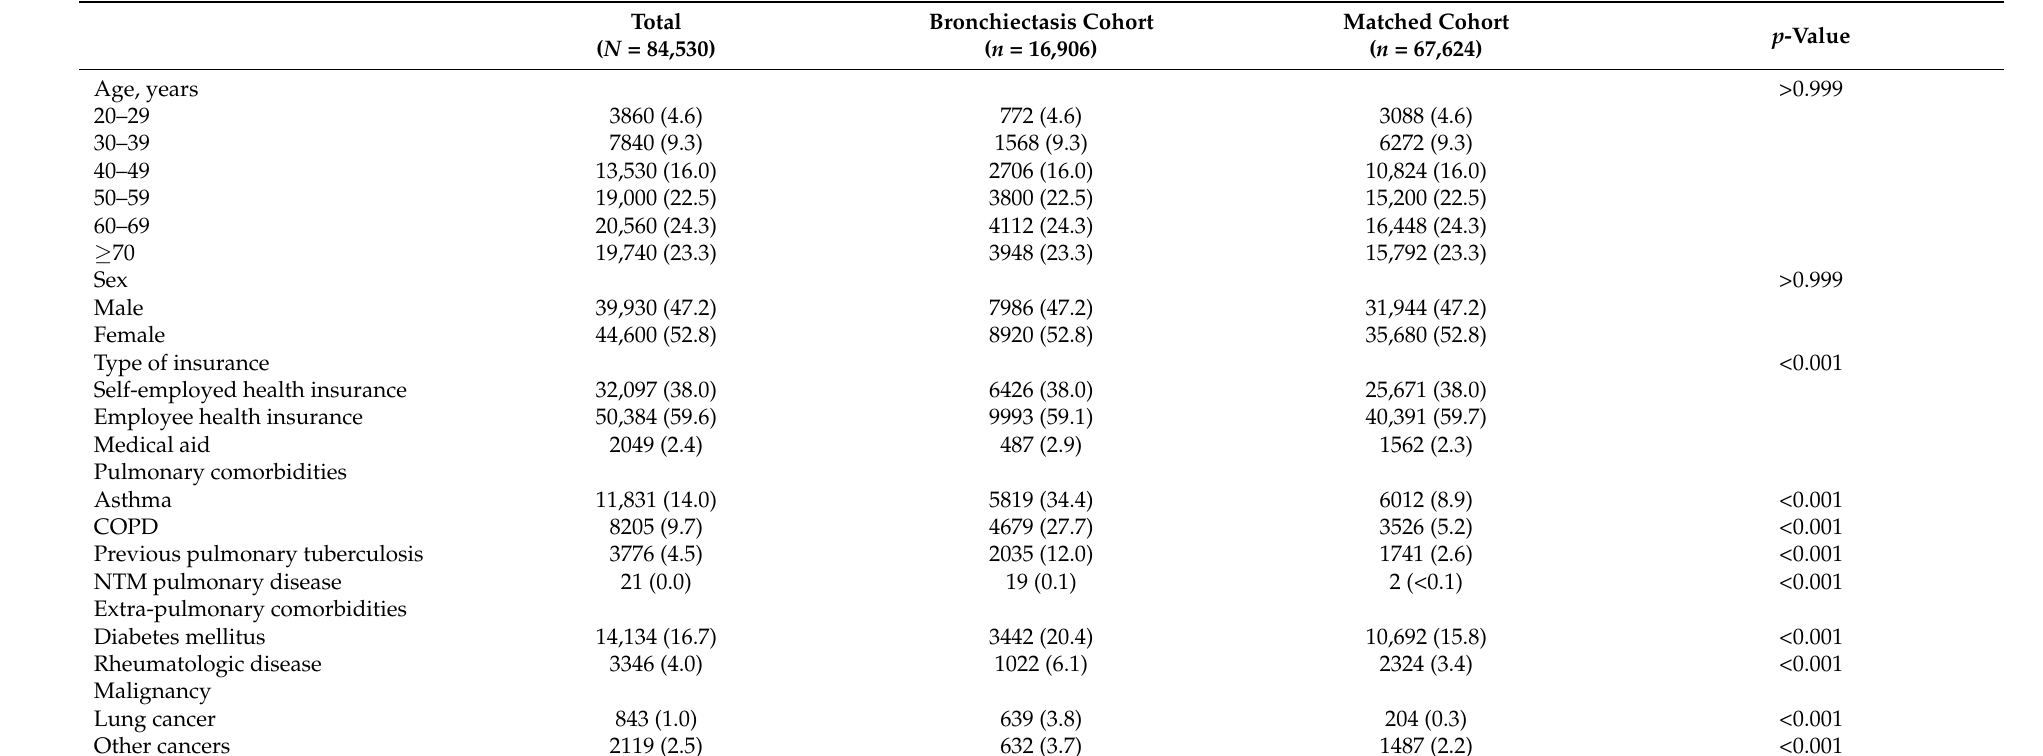
Table 1. Baseline characteristics of